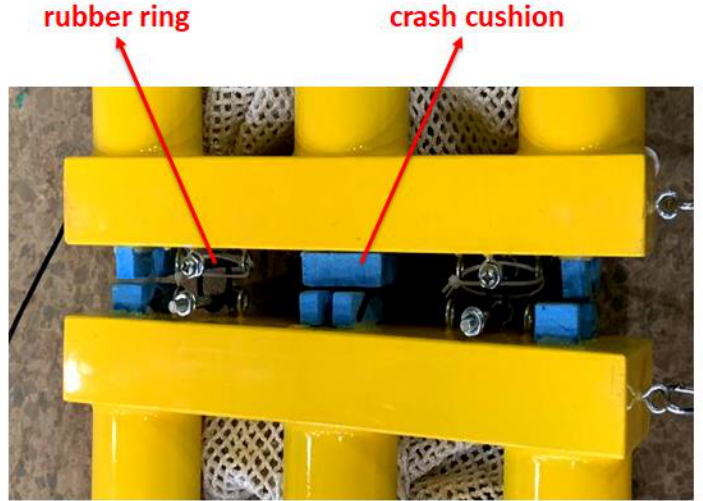
Figure 15. Connectors model diagram.